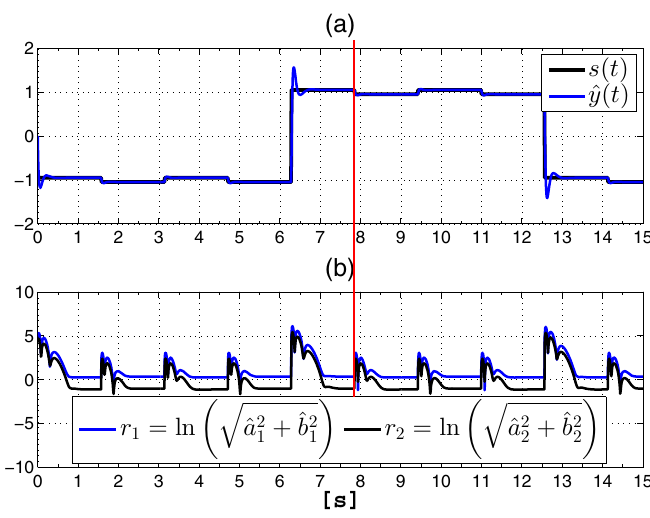
Figure 6. Example 3. ( a ) Signal reconstruction and ( b ) Estimated